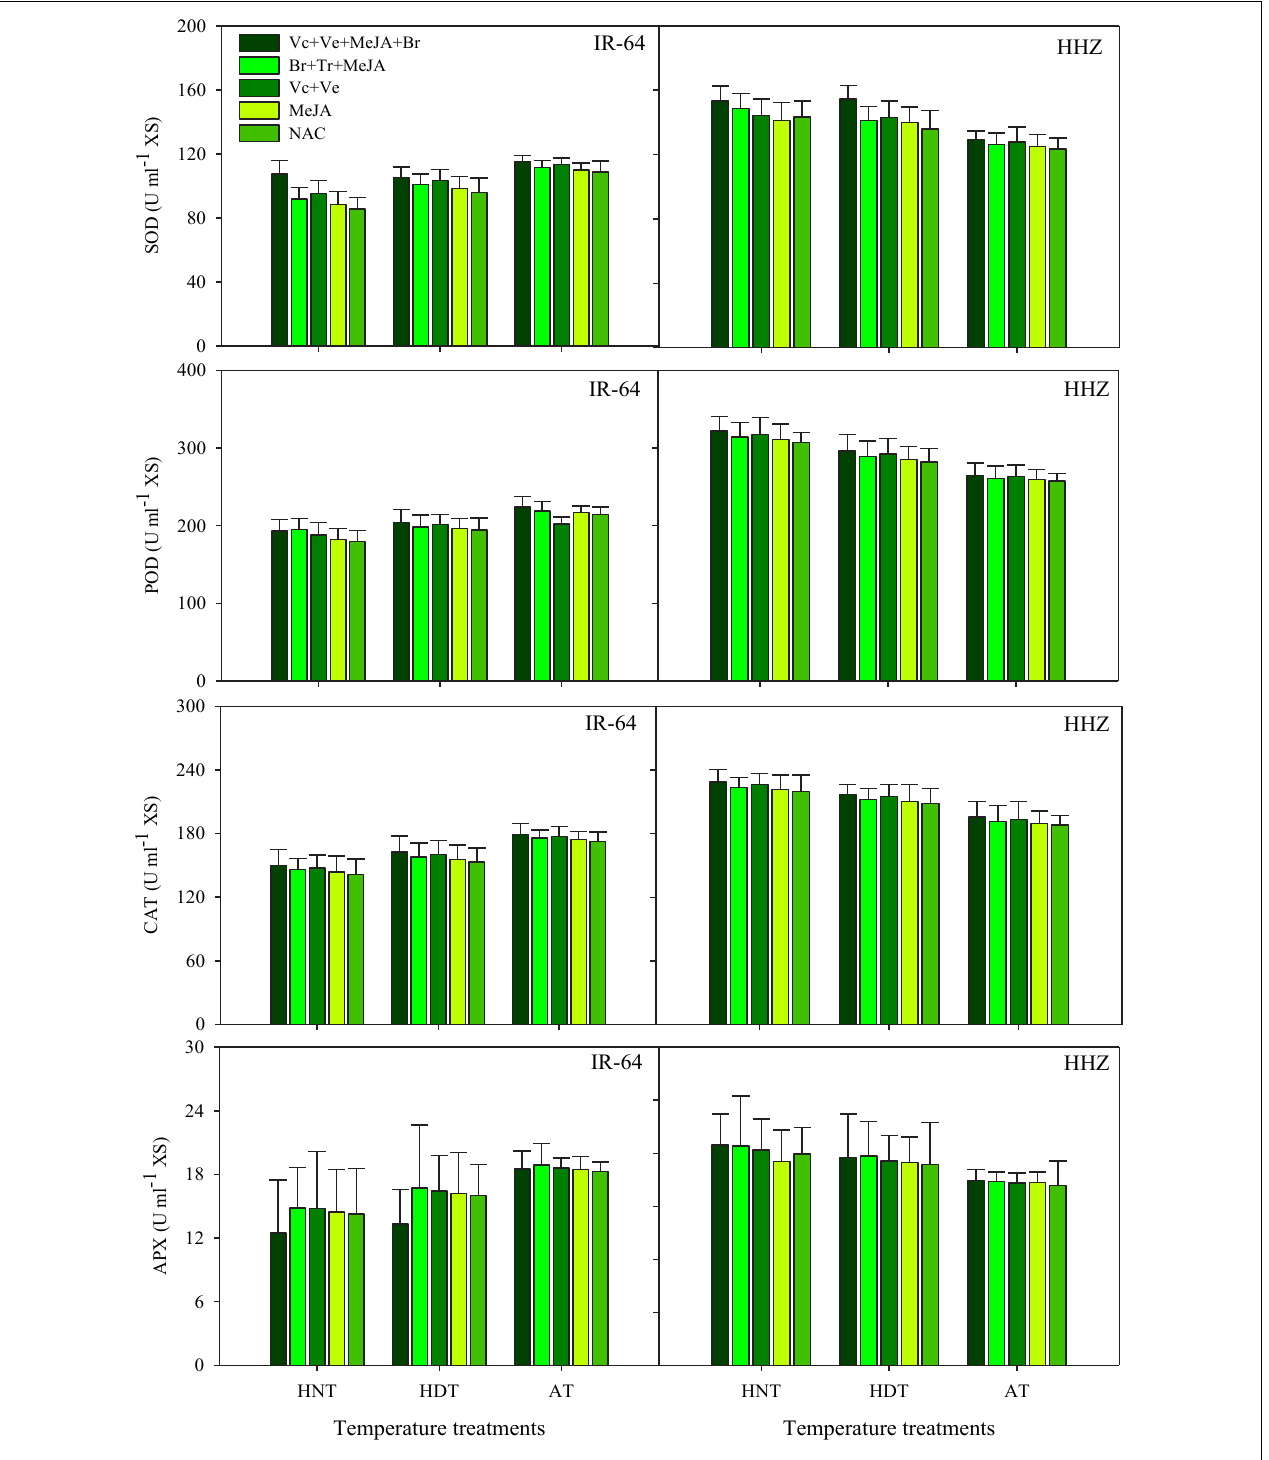
FIGURE 2 | Catalase (CAT), ascorbate peroxidase (APX), superoxide dismutase (SOD), peroxidase (POD) accumulation in the xylem sap of rice as influenced by growth regulators under heat stress. HDT, HNT and AT stand for high day, high night, and ambient temperature, respectively. The lines on bars represent LSD value for the interaction of PGRs and heat stress (heat stress × PGR) at α = 0.05.